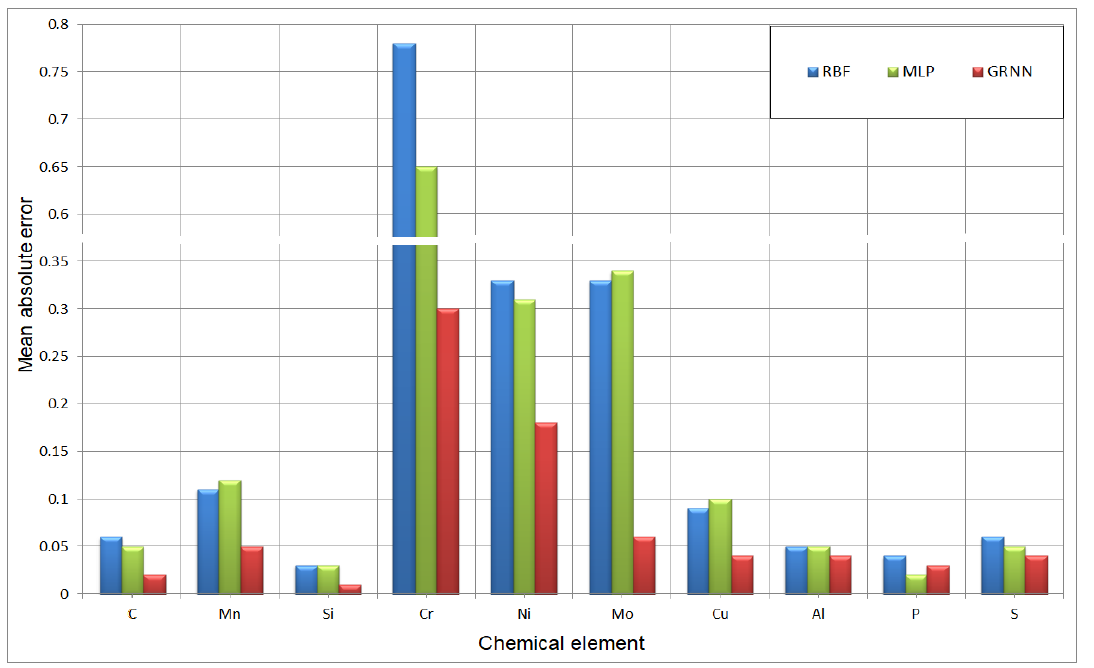
Figure 2. Comparison of mean absolute error for the best achieved artificial neural networks (testing set), build for examinate steels.